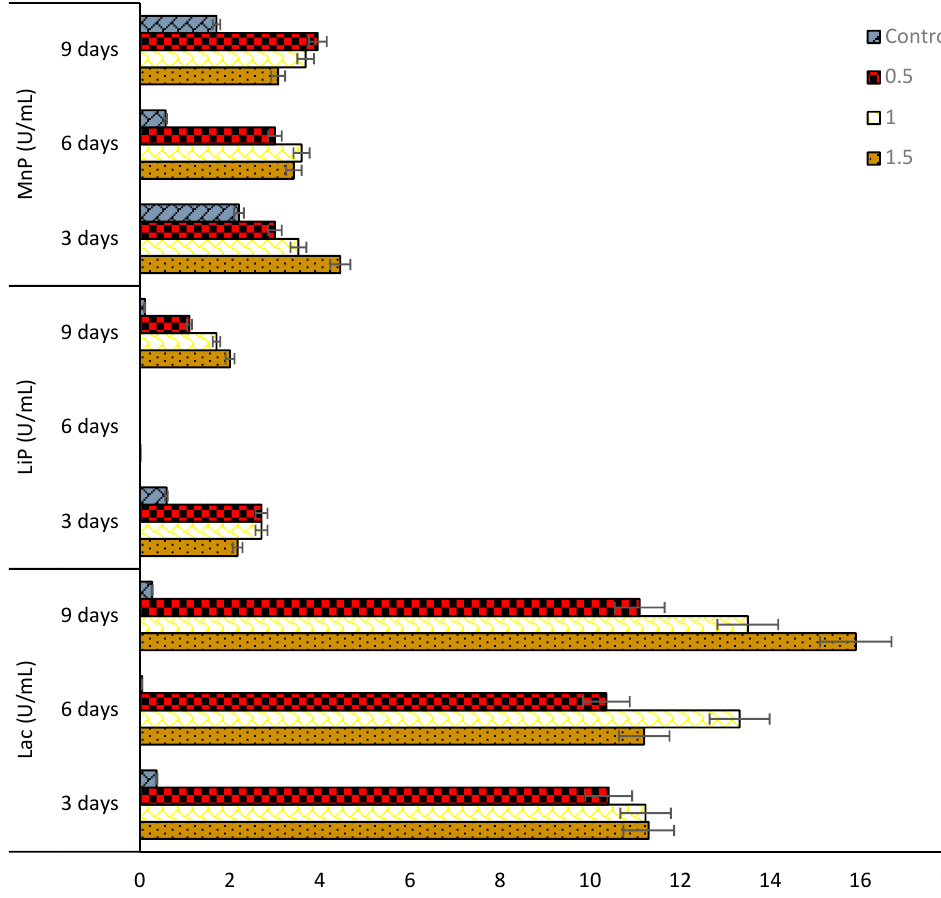
Figure 4. Activities of extracellular enzymes produced by Mucor irregularis B-Yorla10 isolated from a crude oil polluted site in Nigeria.